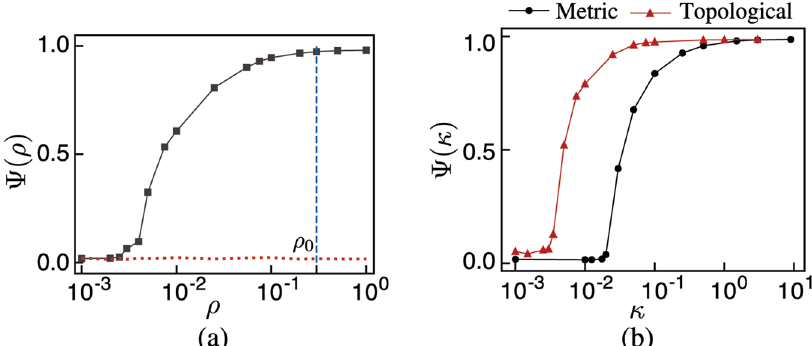
Figure 3. ( a ) Order parameter Ψ as a function of the density ρ for the 3D Vicsek model with periodic boundary conditions (black curve) and in open space (red dotted line). Note the complete absence of ordered states for the case without boundaries. ρ 0 = 0.3 is the initial density used to generate the plots in Fig. 2. This value corresponds to highly ordered states in the standard Vicsek model. ( b ) Ψ as a function of the average long-range connectivity κ for systems moving in open space with short-range interactions implemented metrically (black curve with circles) and topologically (red curve with triangles). In both cases, note the onset of collective order for relatively low values of κ . The complete set of the parameters used in the simulations is listed in Supplementary Tables S2 and